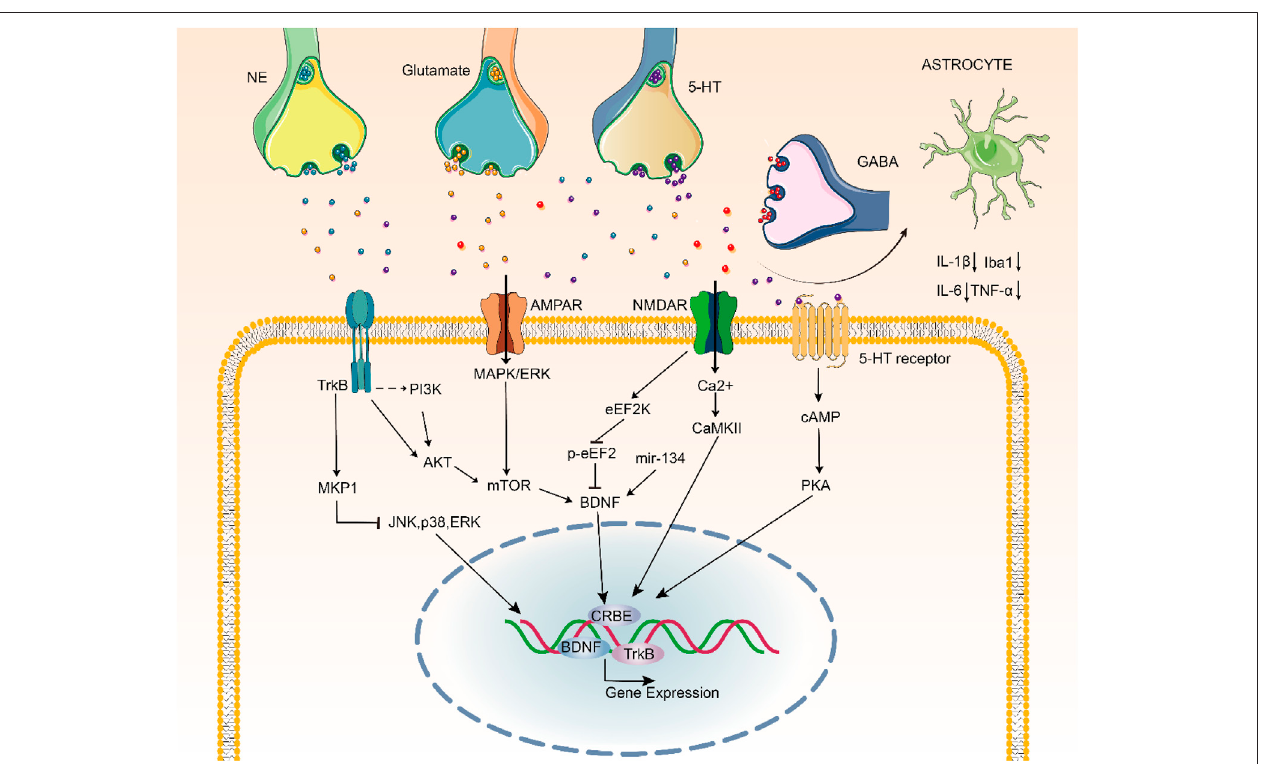
FIGURE 4 | Signaling pathways underlying the pathophysiology and treatment of